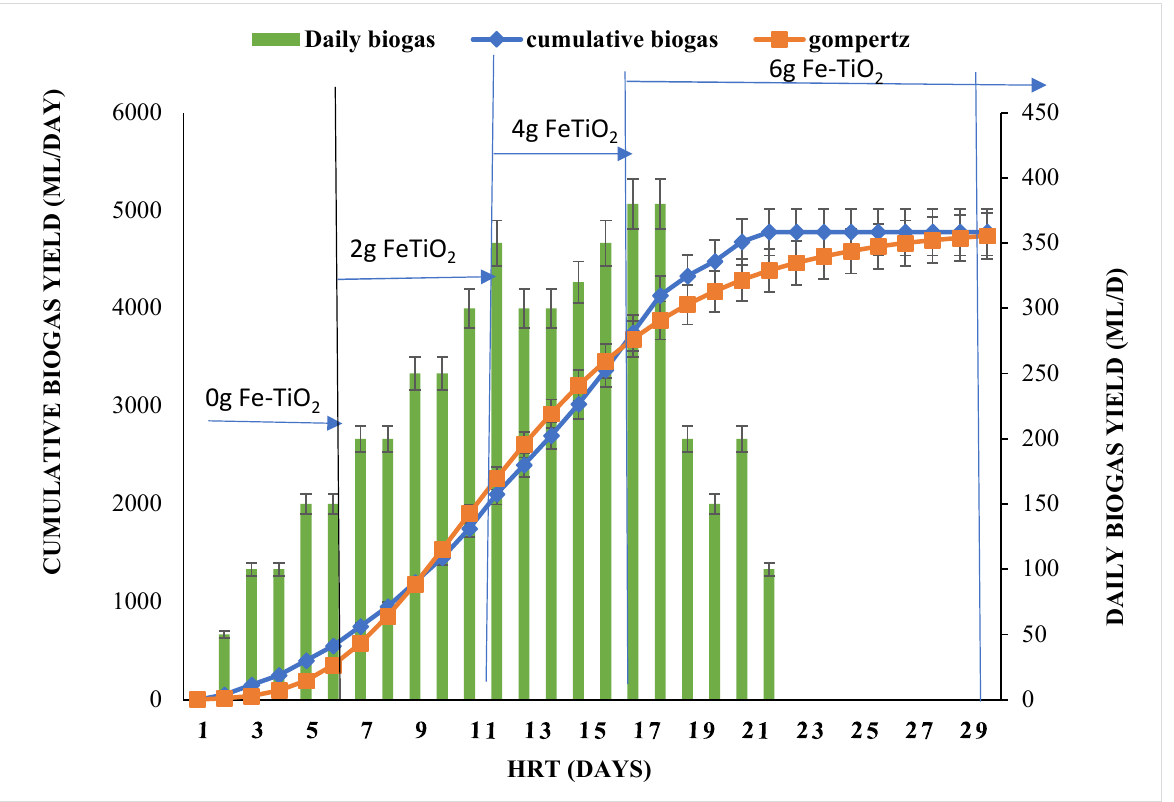
Figure 3. The effect of a weekly catalyst load of Fe-TiO 2 on biogas production using the biophotocatalytic system for 30 days. Table 2. A summary of the modified Gompertz and first order kinetic models for the BP system